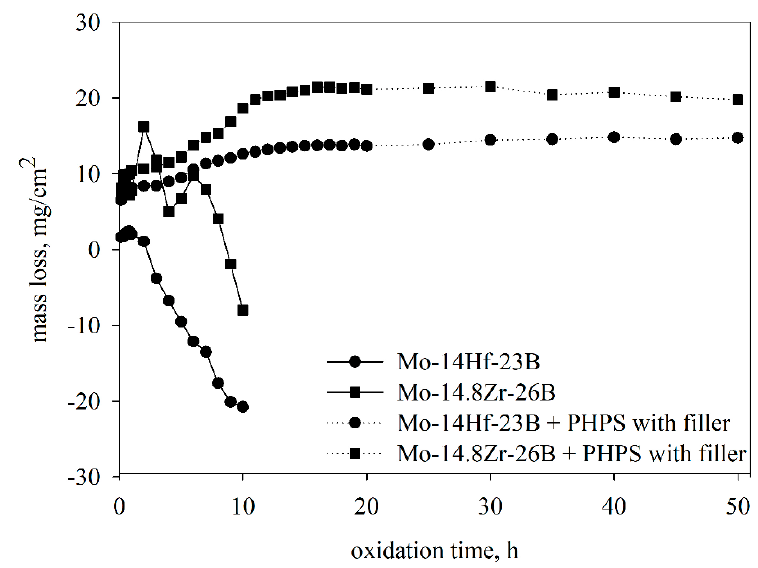
Figure 1 . Mass change curves of uncoated and of coated Mo-14Hf-23B and Mo-14.8Zr-26B alloys under oxidation at 800 °C in air.